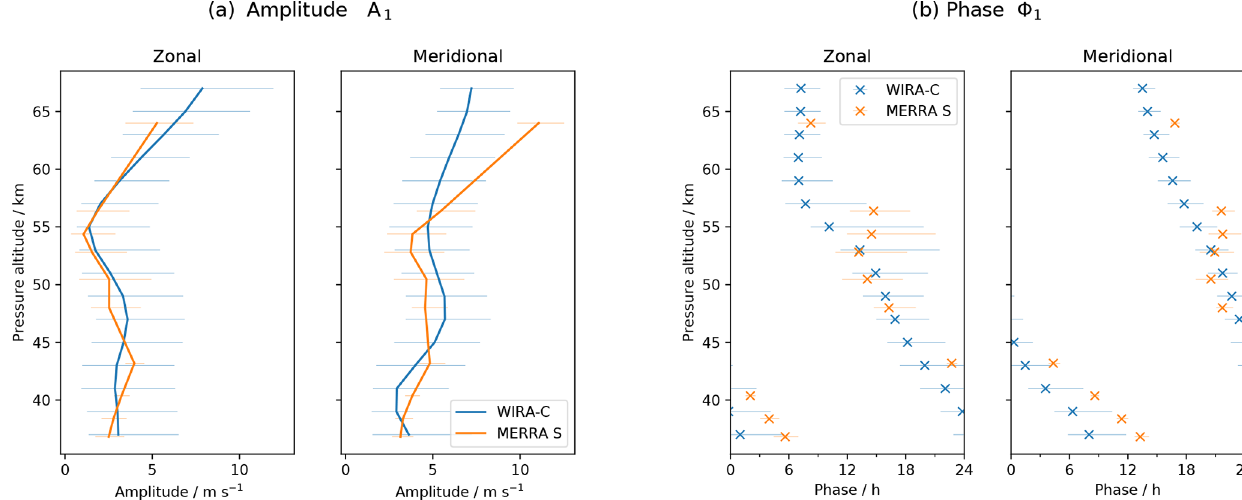
Figure 3. Amplitude and phase of mean daily cycle over 3 months from MERRA-2 reanalysis and WIRA-C measurements from the tropical campaign. Error bars indicate 95% confidence limits. Phase is equivalent to solar time of maximum.